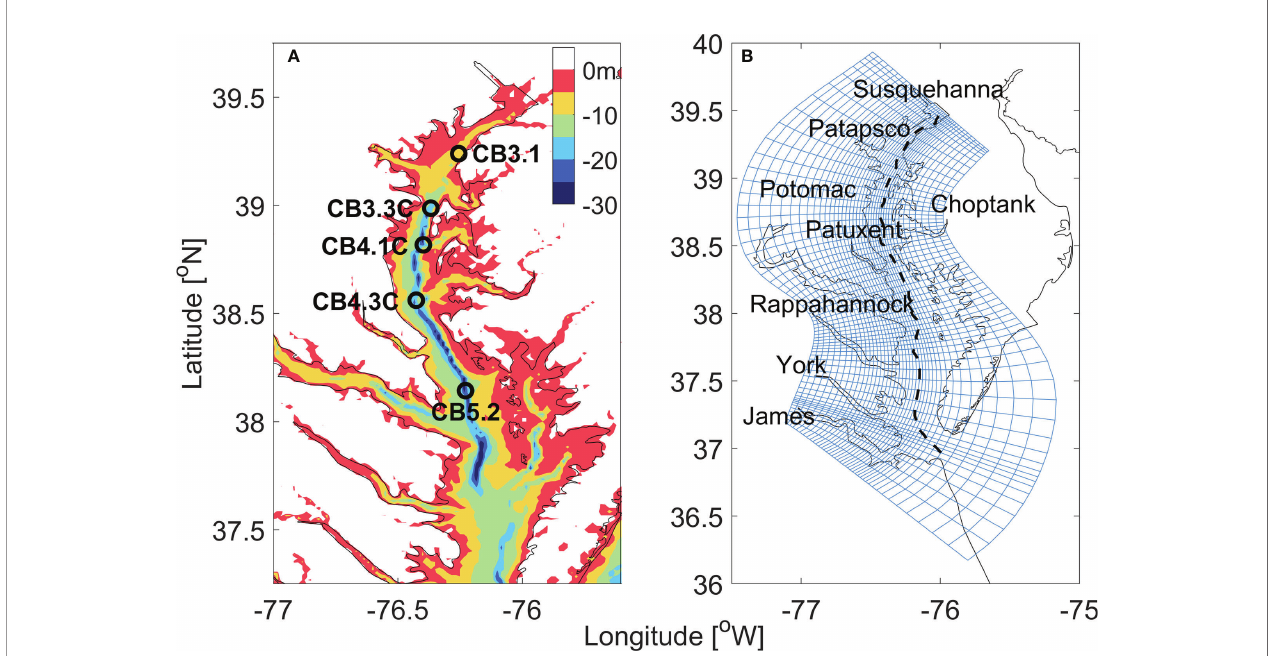
FIGURE 2 | (A) The bathymetry of Chesapeake bay. The open circles mark the location of fi ve sites along the main stem. (B) The horizontal curvilinear coordinate system for ROMS-RCA model, every third grid line is plotted in both along- and cross-bay directions. The black dashed line marks the location of the along-channel section used in later